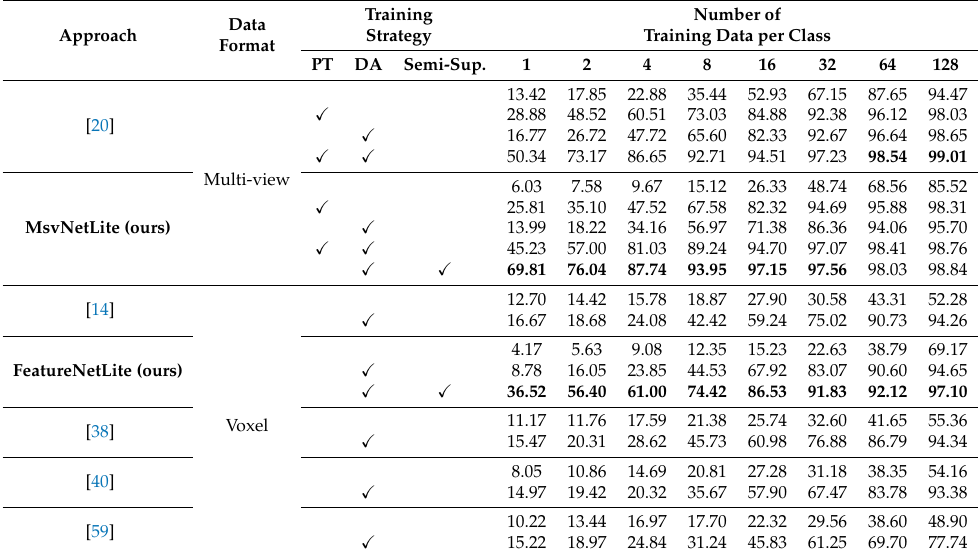
Table 3. The recognition accuracy (%) of several approaches on the FeatureNet test dataset: PT denotes pre-trained weights, DA denotes data augmentation, and Semi-Sup. denotes semi- supervised learning. The bold number is the best result in each